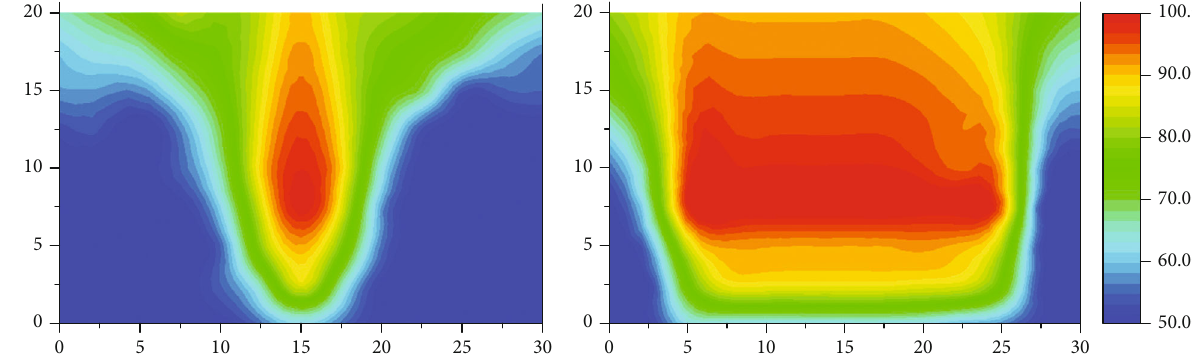
Figure 15: Temperature fi eld in the 3D model during the middle stage of Experiment 3: (a) in the vertical direction of the wells and (b) along the wells.